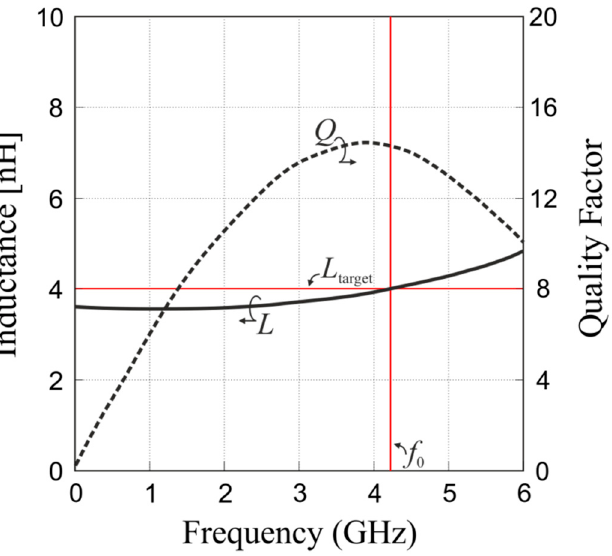
Figure 7. Responses of the compact integrated on-chip inductor at the initial (dashed, ---) and final (solid, -) design solutions. The horizontal and vertical red lines denote the target inductance and the operating frequency f 0 , respectively. Table 4. On-chip inductor optimization results.